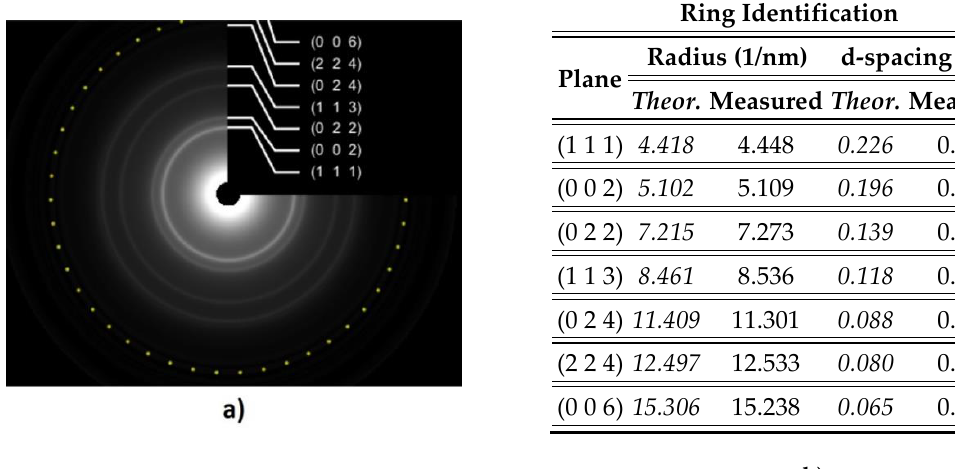
Figure 10. SAED (selected area electron diffraction) investigation for Pt/Si thin films: ( a ) Indexed SAED patterns of Pt/Si film. Inset shows Miller indices for FCC (Face Centered Cubic) Pt; ( b ) Electron diffraction data.